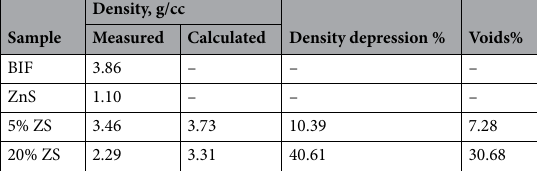
Table 1. Density of BIF and ZS@BIF composites.